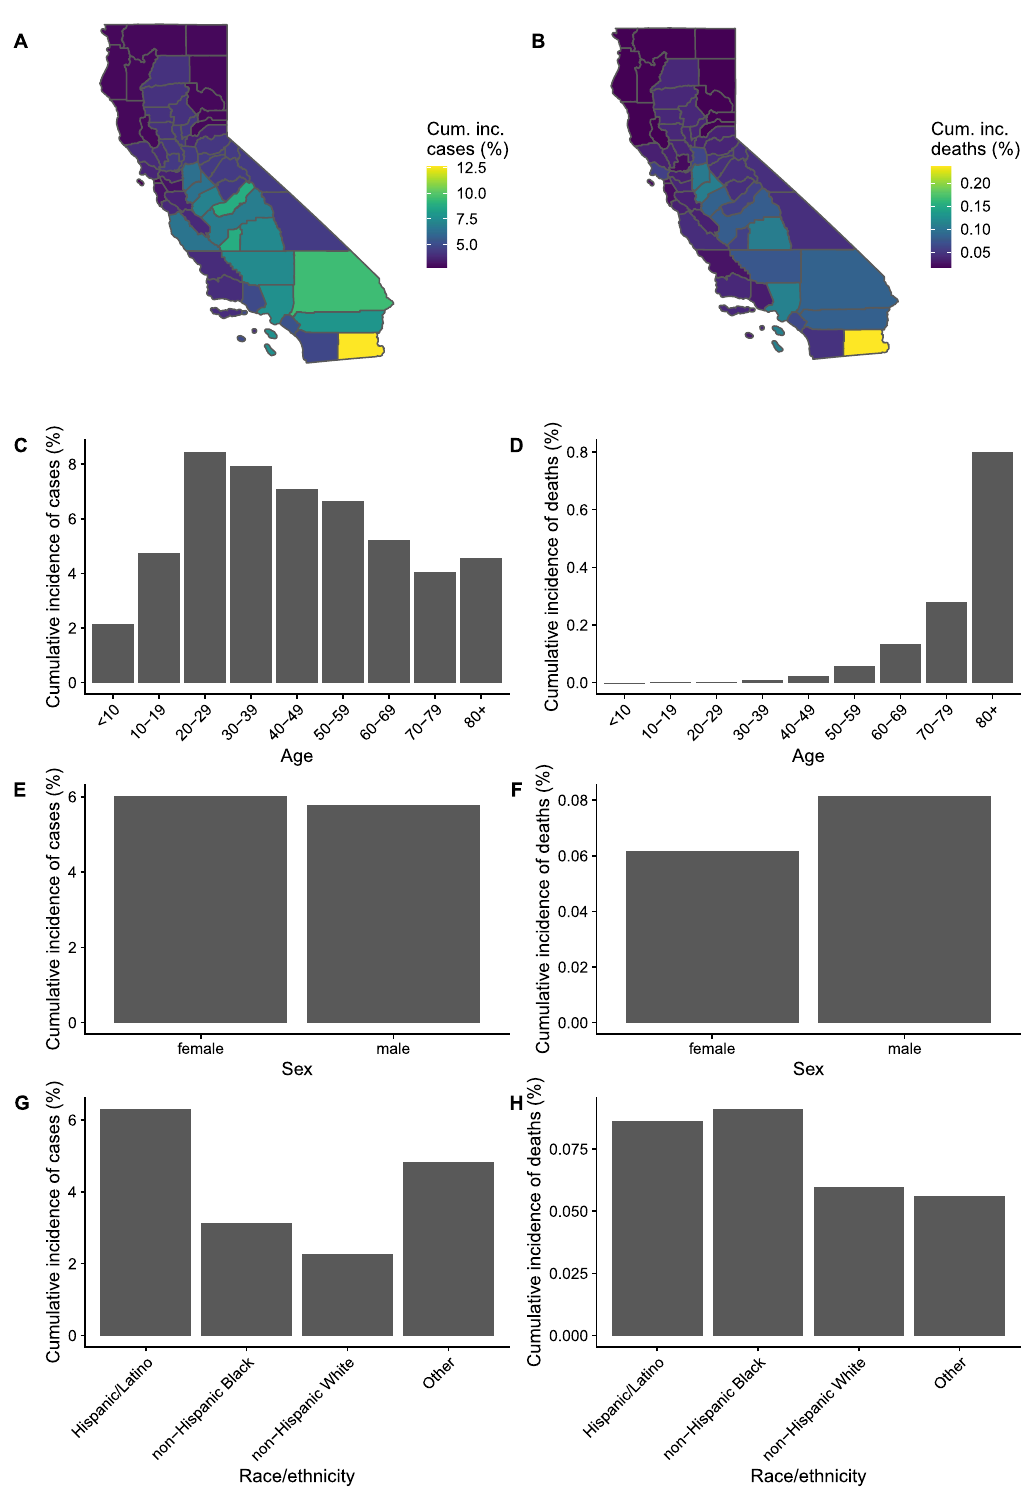
Figure 1. Cumulative incidence of confirmed COVID-19 cases (left column) and deaths (right column) in California up to December 30, 2020, by key demographic factors (rows). Cumulative incidence by ( A , B ) county of residence, ( C , D ) age, ( E , F ) sex, and ( G , H ) race/ethnicity. Data from California Department of Public Health. Counties with population < 250,000 (except Imperial) were combined into a single region by their economic region, San Benito County was combined with Santa Cruz County, and Napa County was combined with Sonoma County. Plotted cumulative incidence for these counties represents the cumulative incidence of the combined